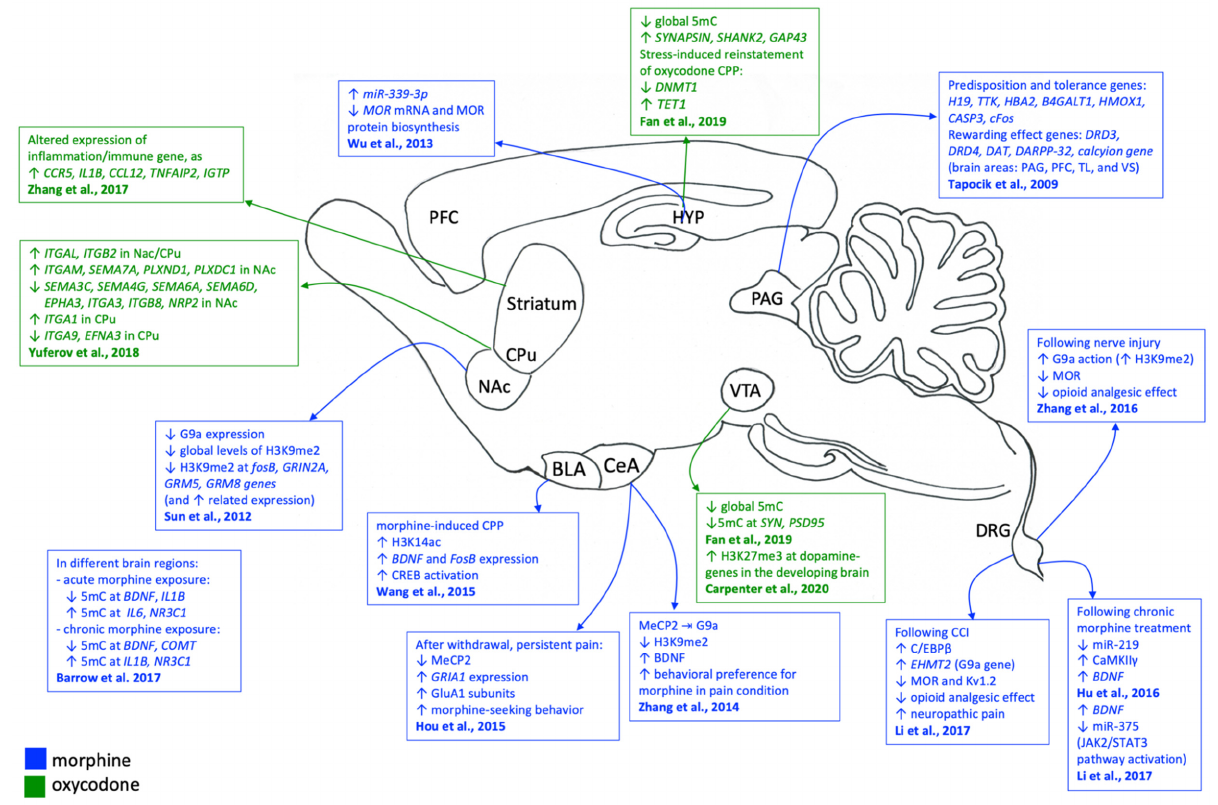
Figure 1. Epigenetic changes detected following chronic prescription opioids exposure in experimental models. Blue color is related to morphine exposure; green color is related to oxycodone exposure. Symbols meaning: ⇥ repression; ↓ decreased expression/repression; ↑ increased expression/activation 3.2.2. Human studies.